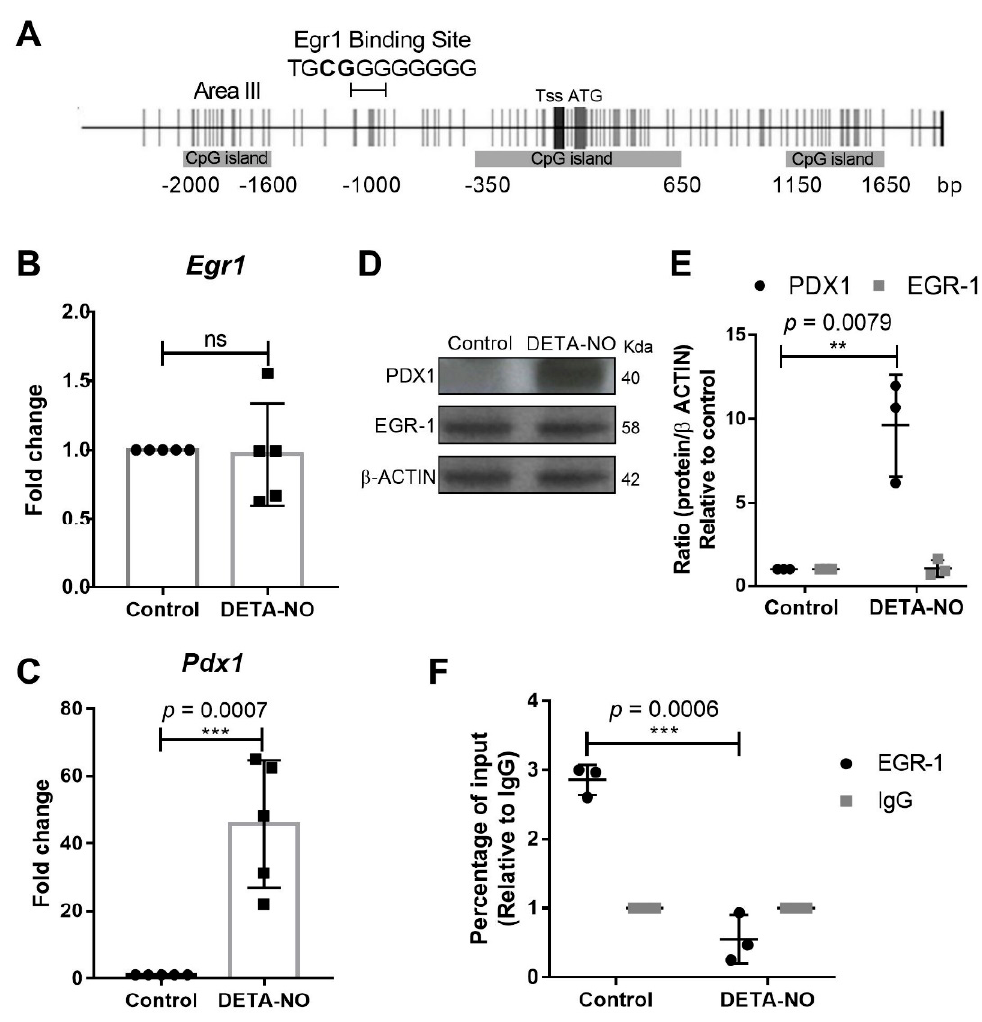
Figure 1. EGR-1 binds to Pdx1 promoter in mESCs. ( A ) Pdx1 promoter scheme shows CpG sites (vertical gray lines), CpG islands (horizontal gray rectangles), transcription start site (TSS) and trans- lation start site (ATG) represented by vertical gray rectangles, and EGR-1 consensus sequence (TGCGGGGGGGG) on Pdx1 according to the JASPAR database and regulatory area III (Area III). Analysis of ( B ) Egr-1 and ( C ) Pdx1 expression after DETA-NO treatment by real time-PCR. These values were normalized to expression values of β -actin, used as the loading control and analyzed using the ∆∆ Ct algorithm. They represent the average of five independent experiments. Data are means ± standard deviation (SD). ( D ) PDX1 and EGR-1 expression were analyzed by Western blot- ting in control and DETA-NO conditions. β -actin was used as loading control. The image shown is the most representative of three independent experiments. ( E ) Western blotting quantification of three independent experiments of PDX1 and EGR-1 proteins, relativized to β -actin expression, using ImageJ software. ( F ) Chromatin immunoprecipitation (ChIP) assays of EGR-1 on Pdx1 promoter at JASPAR database-predicted location in mESCs. Result shows the means ± SD of three independent experiments. Y-axis corresponds to the percentage input relativized to IgG binding. Data with ** p < 0.01 or *** p < 0.001 were considered statistically significant.